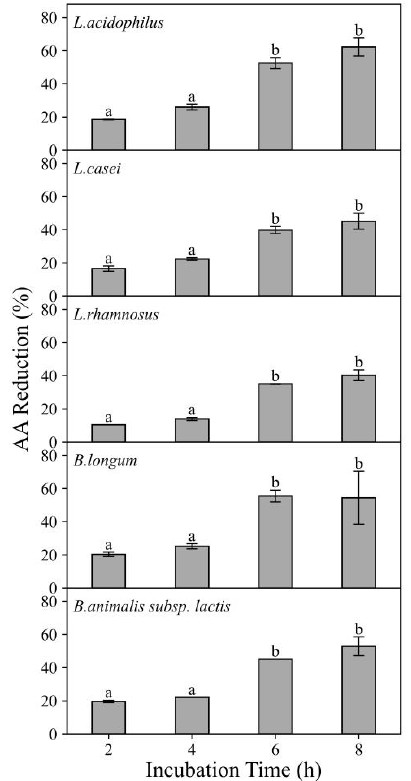
Figure 3. Effects of incubation time on the acrylamide (AA) reduction ability of five strains of probiotic bacteria at 10 9 CFU/mL when exposed to 750 ng/mL AA solutions for 2 – 8 h. Incubated at 37 °C at pH 6.5 – 7.0. Expressed as AA reduction percentage. Different characters in each panel indicate significant differences, whereas same character indicate no significant difference.